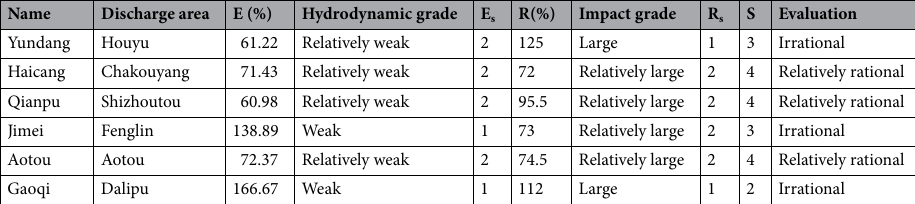
Table 9. Comprehensive evaluation of sewage outfalls in XMB in